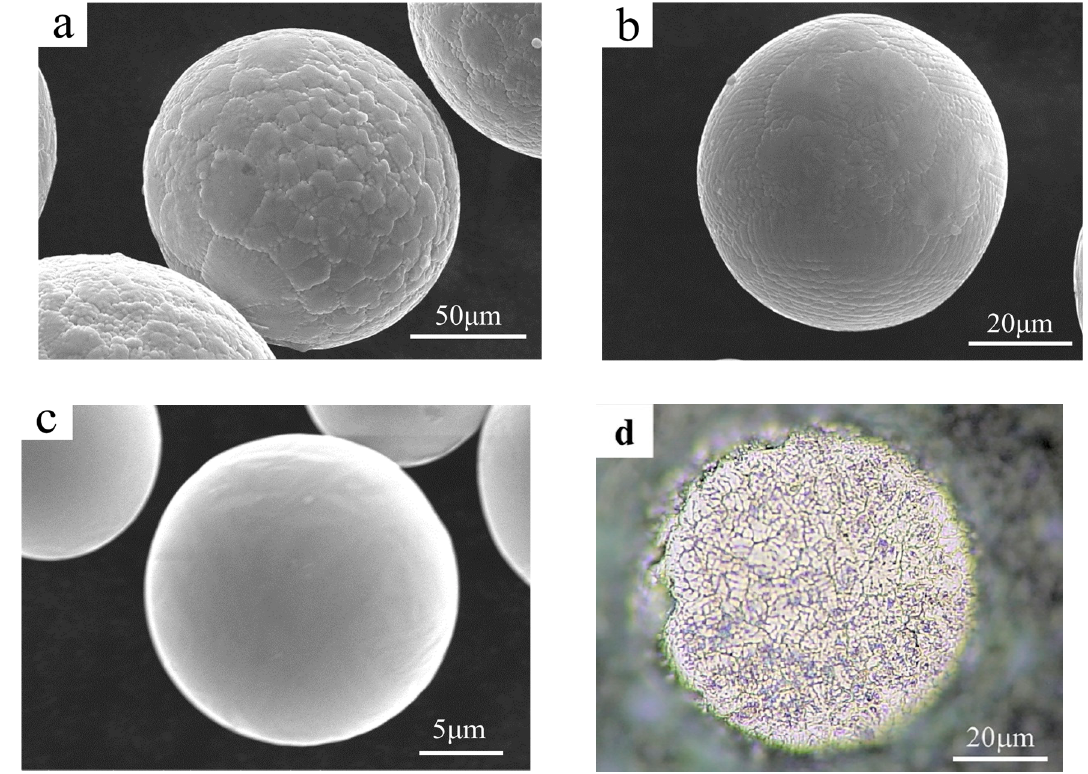
Figure 2. SEM surface morphology of the as-atomized high-Nb TiAl powder with different sizes: ( a ) large size (>100 µm); ( b ) medium size (45–75 µm); ( c ) fine size (<15 µm). ( d ) The cross-sectional microstructure of the medium powder.